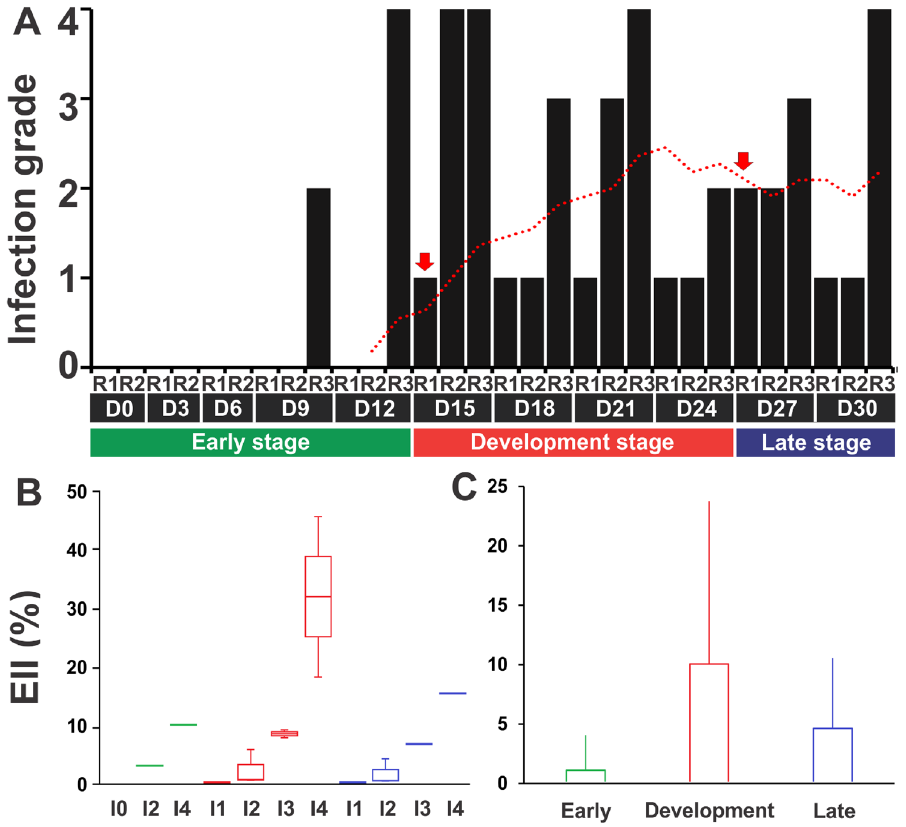
Figure 3. Evaluation of EHP infection. ( A ) EHP infection grade (I0–I4) registered during the bioassay and EHP infection index (EII) values according to ( B ) infection grade by each disease stage and ( C ) mean value for each disease stage. Black bars denote the infection grade of each organism sampled. The red dotted line represents the average of black bars considering 3 sampling days. Red arrows represent the beginning and the end of each disease stage. Color bars cluster the organisms from early (green), development (red), or late (blue) stages of the disease. R: replicate (sampled shrimp); D: day (sampling day). EII values are represented as mean ± standard